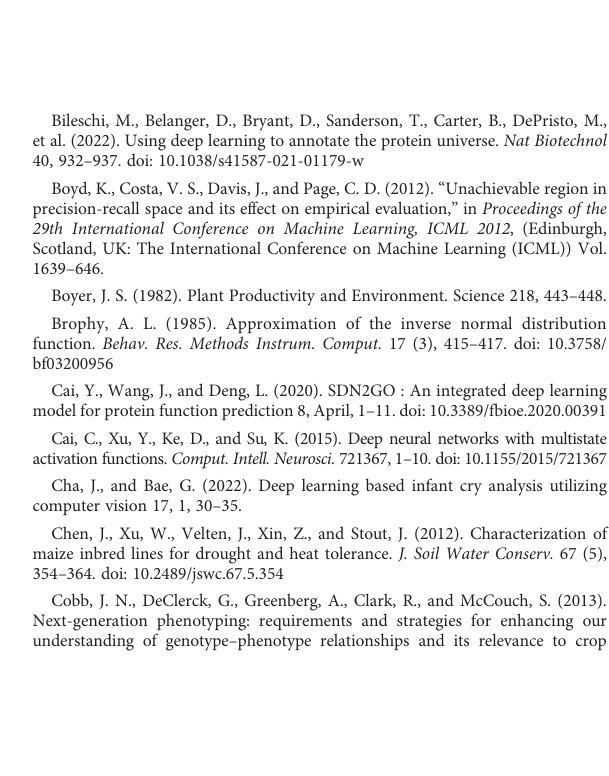
SUPPLEMENTARY FIGURE 1 Precision-Recall curve of different abiotic stress data. SUPPLEMENTARY FIGURE 2 Receiver Operating Characteristics curve of different abiotic stress